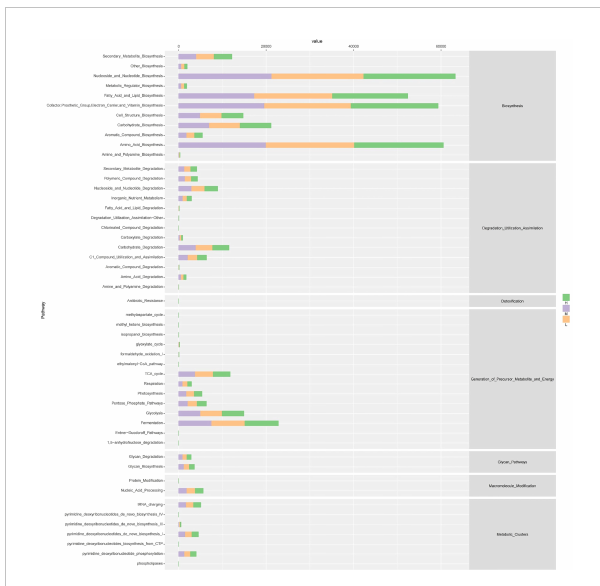
FIGURE 7 The outline functional analysis among H, M and L